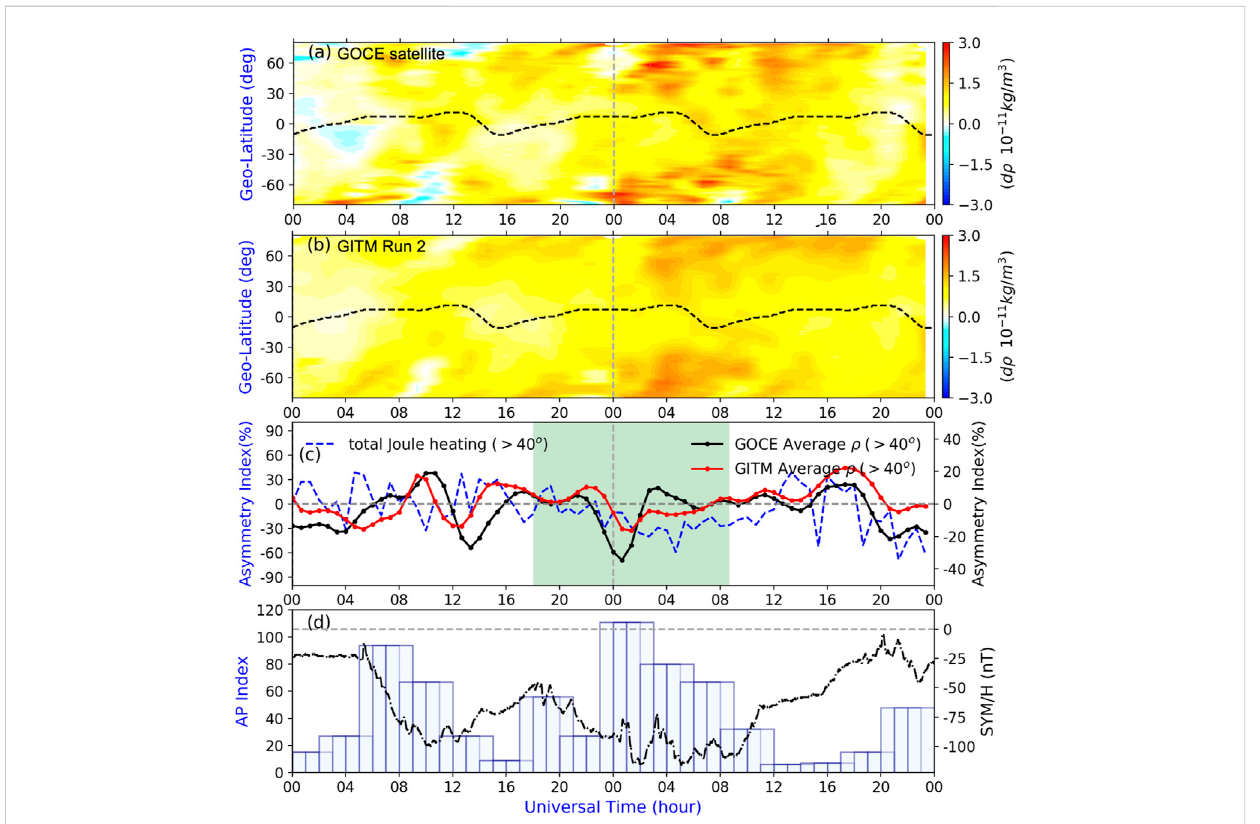
FIGURE 9 (A, B) Neutral density at the dusk side from the GOCE trajectory observation normalized at 270 km and GITM run 2 (driven by data-based realistic patterns)-simulated results sampled along the GOCE trajectory as functions of geographic latitude and universal times during the October 8 – 9, 2012, geomagnetic storm, respectively. The black dashed line refers to the dip equator. (C) Temporal changes of the asymmetry index for total Joule heating (hemispheric-integratedJouleheating,bluedashedline)fromGITMrun2(labelontheleft y -axis);thetemporalchangesoftheasymmetryindexfor averaged density in the mid- and high-latitudes ( > 40 ° |GLAT|) based on the 2-D contour for GOCE (black dot line) and GITM run 2 (red dot line) with the label on the right y -axis. To have a general view of the storm-time response of the neutral density, (D) gives the geomagnetic activity information: the 3- hourly Ap index (blue) and SYM/H index